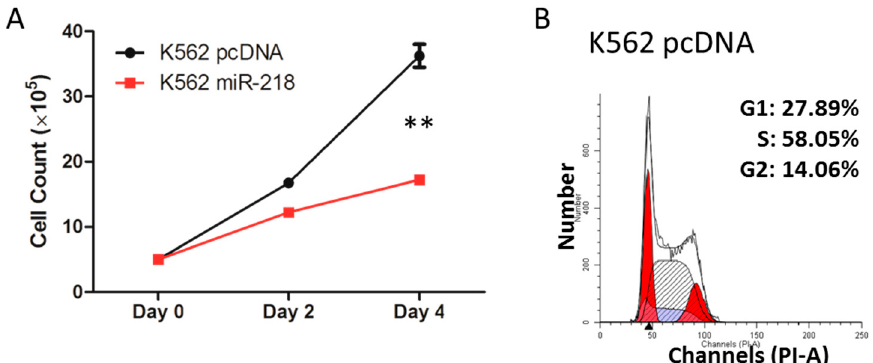
Figure 7. Cont. Figure 7. Cont